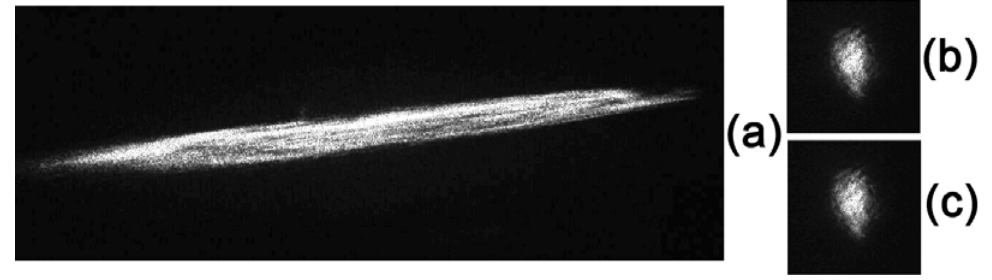
Figure 24. Results of compensation of a model phase distortion of the type of an astigmatic lens: ( а ) the focal distribution with a distortion of the type of an astigmatic lens (+1.25) and without phase conjugation; ( b ) the distribution with phase conjugation compensation of the lens and ( c ) a phase conjugation wave without distortion. All images are given in the equal